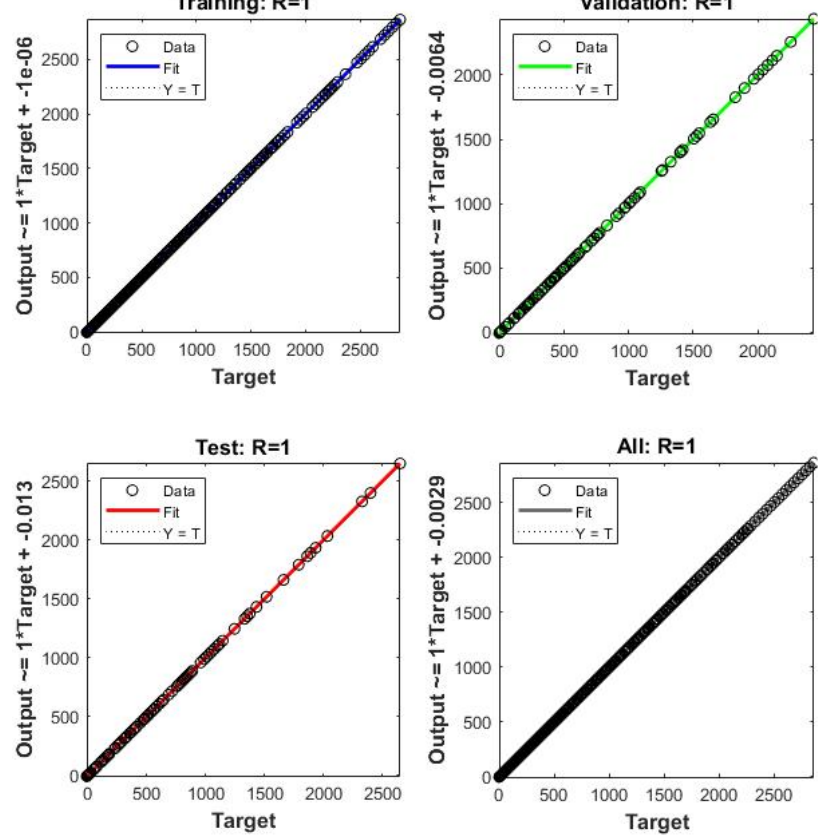
Figure 7. Regression analysis of all three phases and overall